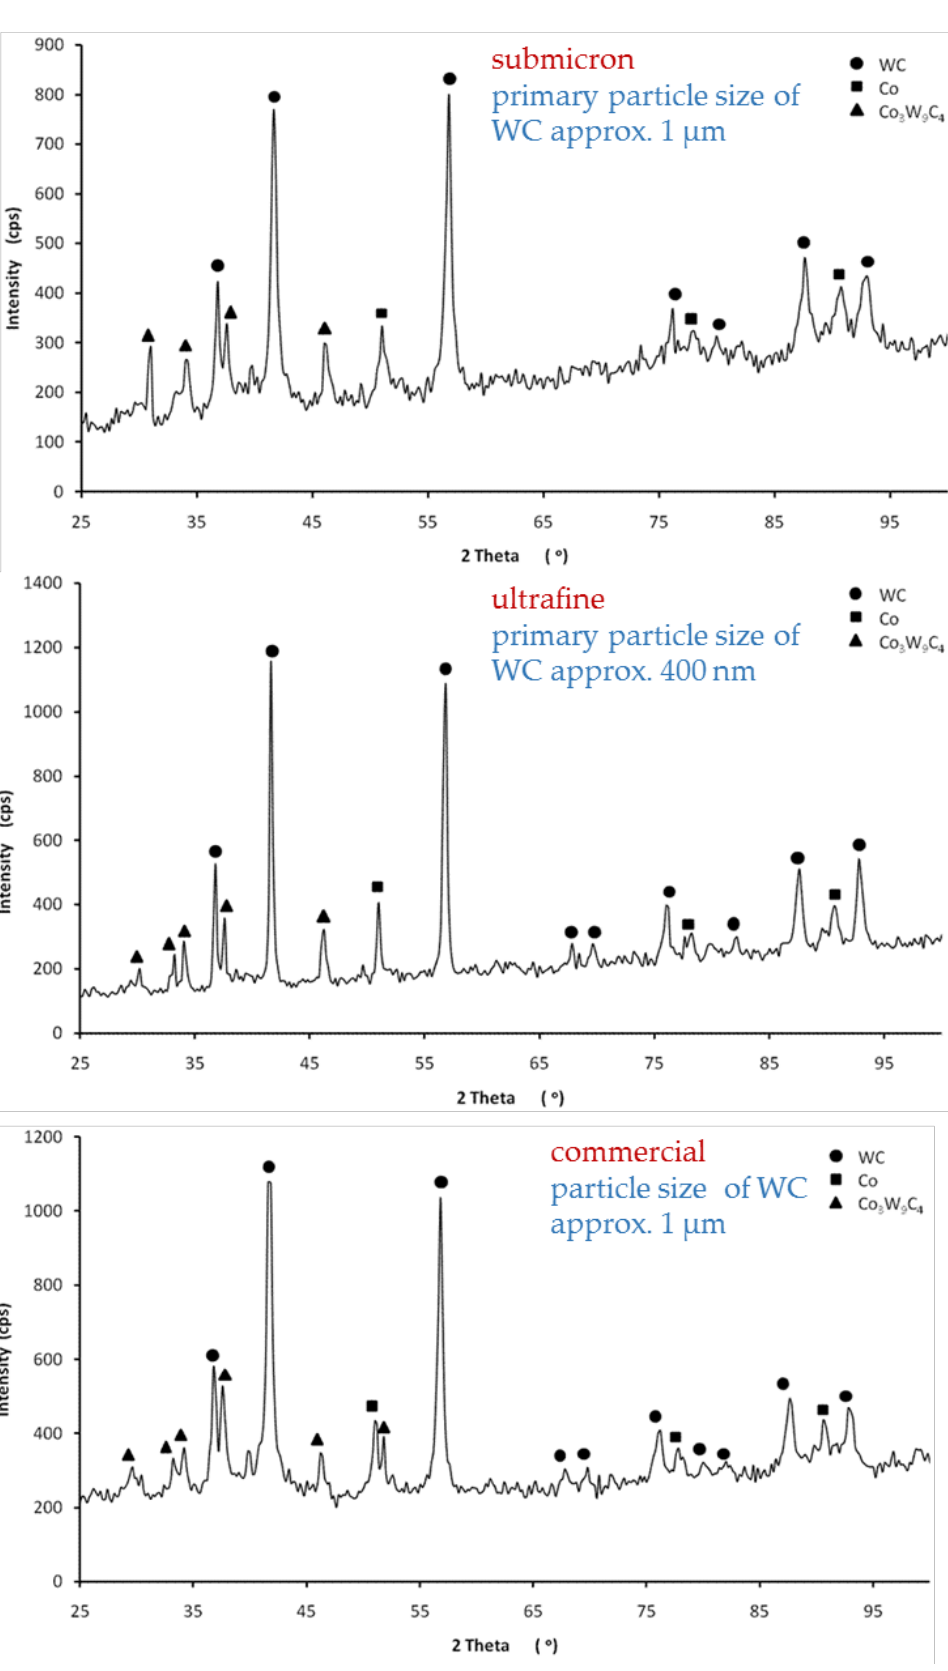
Figure 6. Diffraction analysis of the composites studied.